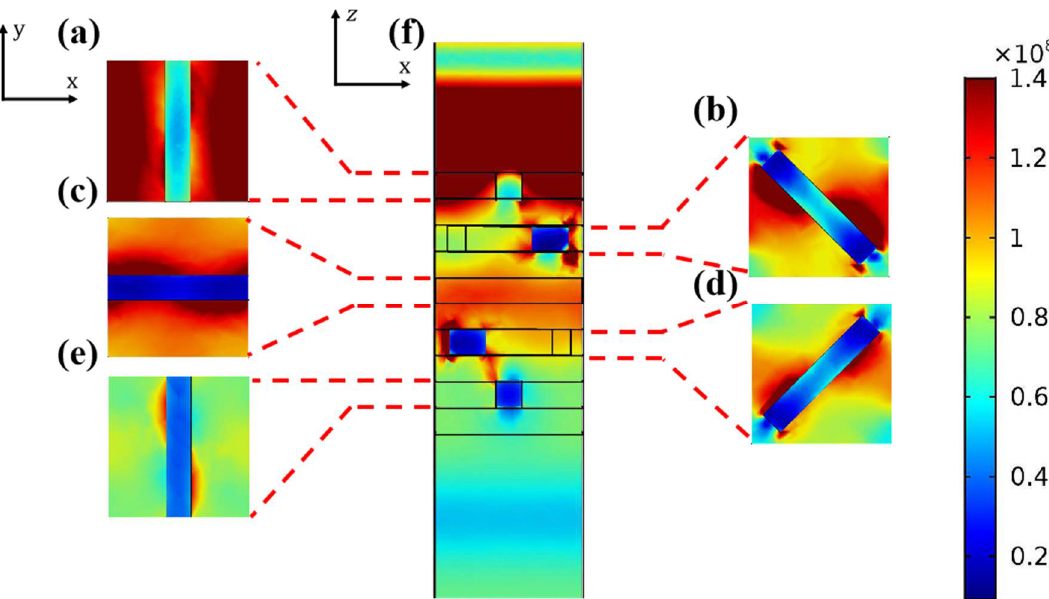
Figure 2. Electric field concentration of our proposed LHDCP for: ( a ) first (top) layer of Al nanograting aligned along the y -axis, ( b ) second layer of Al nanocuboids rotated 45 ◦ around the z -axis, ( c ) third layer of Al nanograting rotated 45 ◦ so it now aligns with the x -axis, ( d ) fourth layer of Al nanocuboid rotated around the z -axis by 45 ◦ , ( e ) fifth layer of Al nanograting rotated so it now aligns again with the y -axis, ( f ) Electric field cross-section of DCP model in the x-z plane.